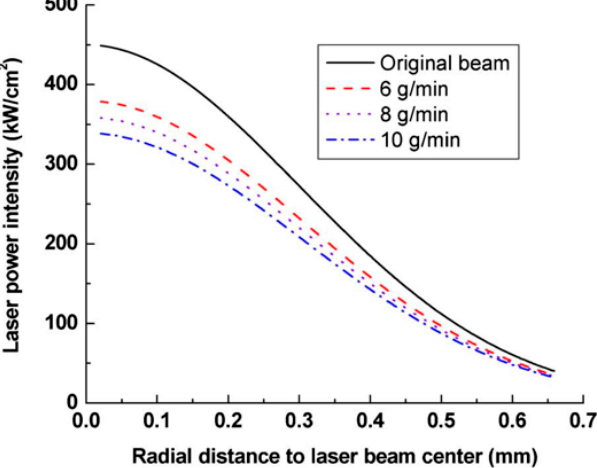
Figure 16. Resulting laser power intensity at different values of powder flow rate (reproduced with permission from [82]; Copyright © 2007 AIP Publishing).